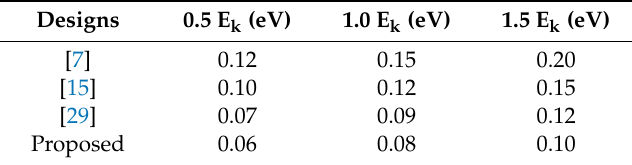
Table 7. Energy dissipation analysis at T = 2 K.